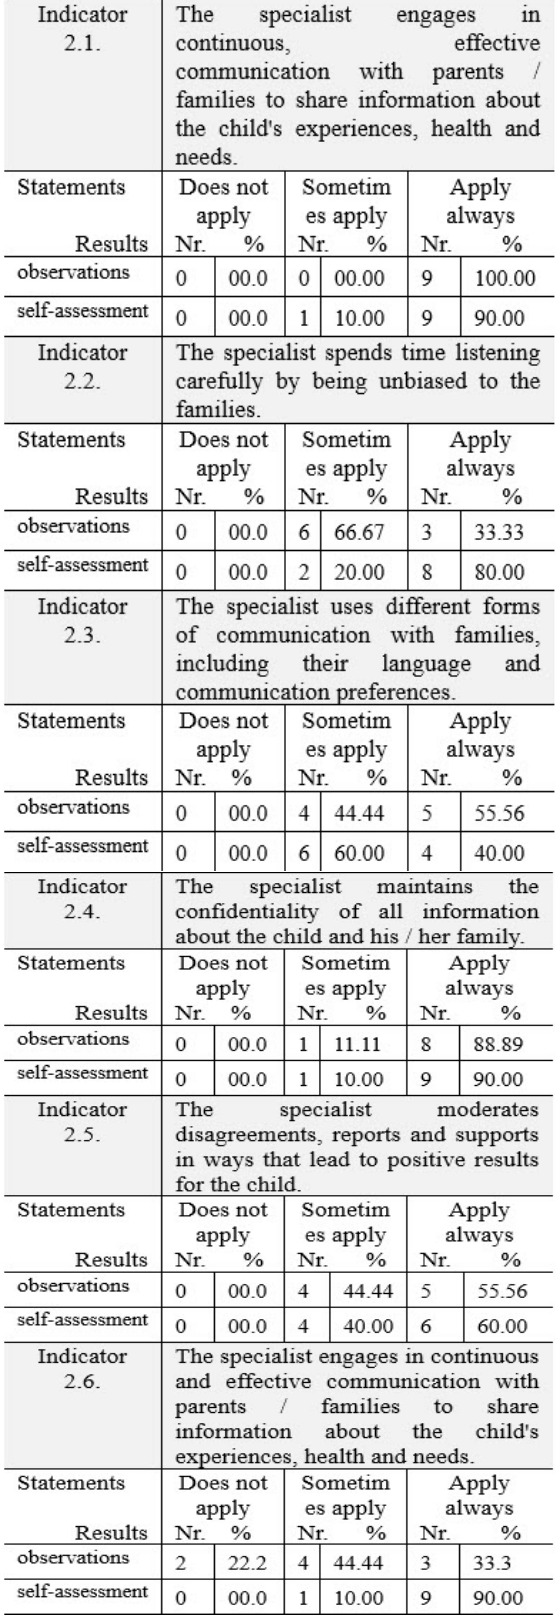
Table 7. Principle 2: Sensitive, respect - ful and equal communication with families supports the development and learning of chil -